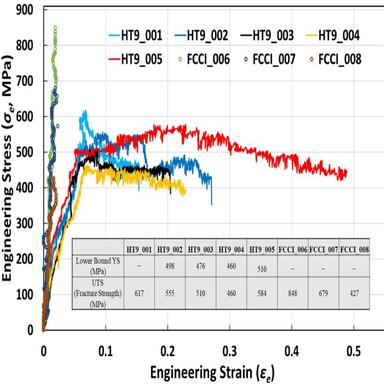
The engineering strain-stress curves for fabricated micro-tensile bars from the HT9 cladding as indicated in 1. The lower bound yield strength (YS) and ultimate tensile strength (UTS) for each test were tabulated and inserted. For FCCI specimens which showed brittle fracture, the UTS is equal to fracture strength.